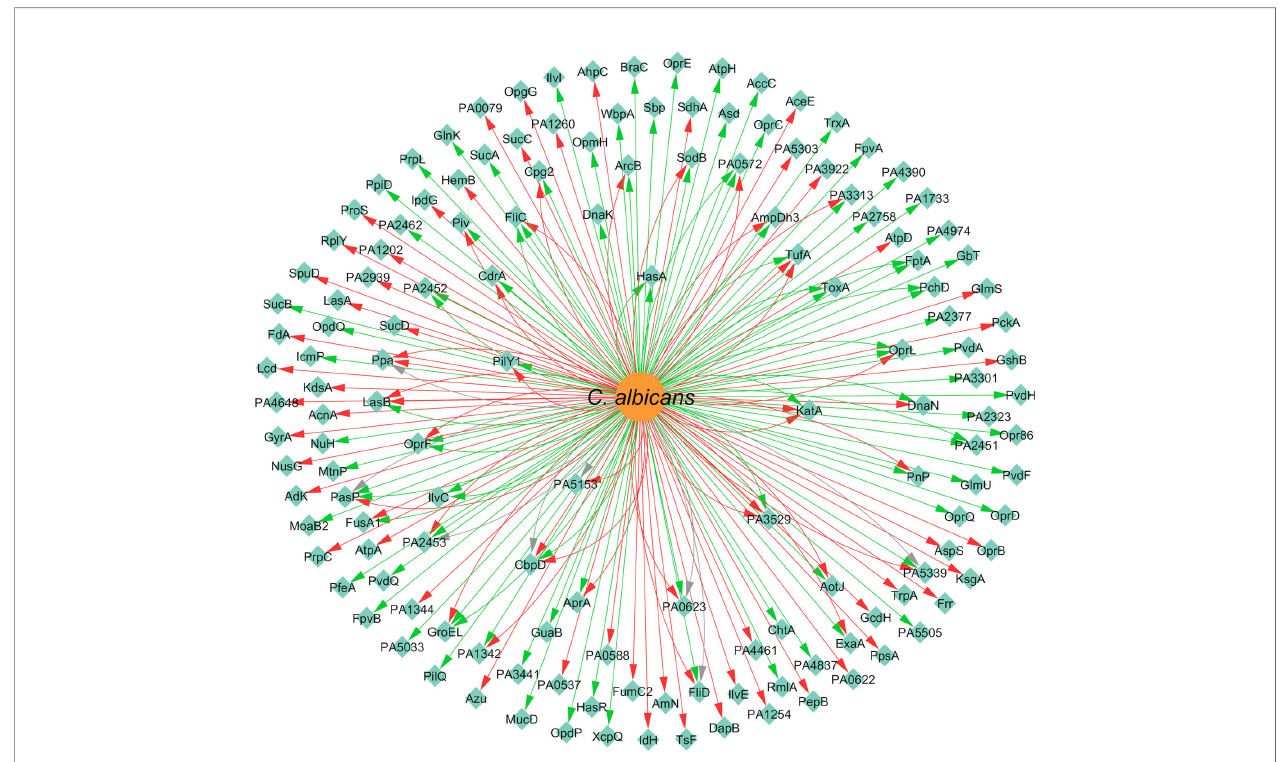
FIGURE 9 | Network of the effects of C. albicans on P. aeruginosa protein expression. Legend: Teal nodes, P. aeruginosa ; orange nodes, C. albicans ; green arrows, upregulation; grey arrows, null effect; red arrows: downregulation; node and node label sizes are directly proportional to the number of related (outward and inward) edges